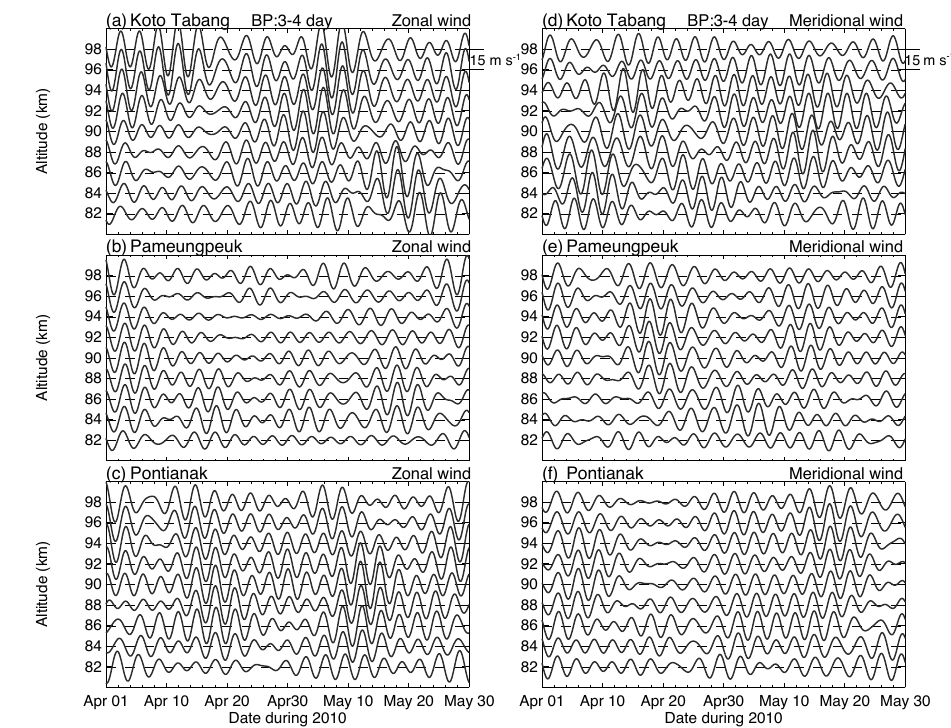
Figure 7. The band-pass filter results of the zonal (a, b, c) and meridional (d, e, f) at Kototabang, Pameungpeuk, and Pontianak locations. The bandwidth is 3–4 days and the interval is 15ms − 1